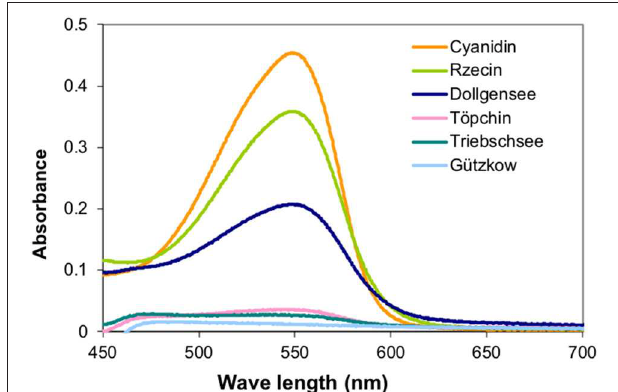
FIGURE 3 | UV spectra of the colored anthocyanidins formed during the acid butanol assay were conducted to verify the quality of separated PAs and their suitability as internal standards for pristine